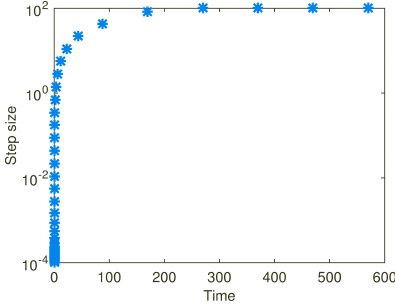
numerical solution at time t f = 569.6 for the KDC method with 8 Radau II node and full outer Newton iterations for a reference solution, since analytic solutions of this problem are unknown.